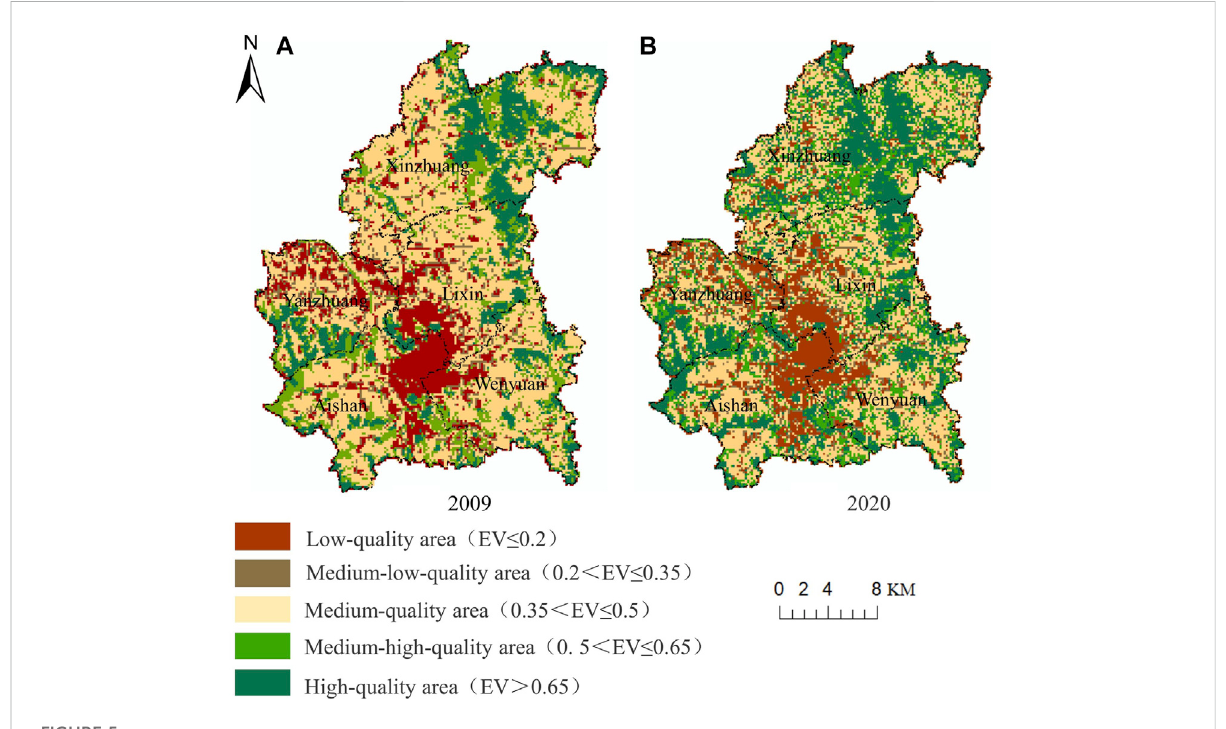
FIGURE 5 Spatial distribution of the eco-environment quality levels. Note: EV is the eco-environmental quality index of each ecological